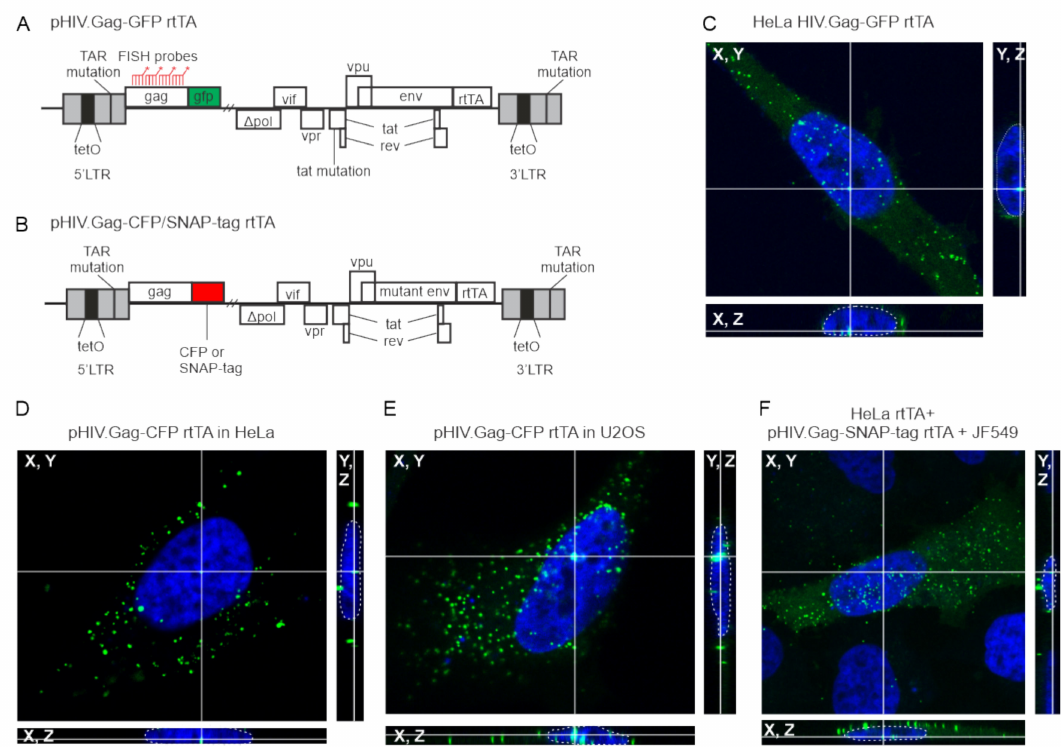
Figure 1. HIV-1 Gag foci are present in the nucleus of HeLa and U2OS cells regardless of the nature of the tag fused to the C-terminus of Gag, which was expressed in a Rev-dependent fashion using the constructs shown in panels A and B. ( A ) Schematic of doxycycline-inducible HIV.Gag-GFP rtTA proviral construct expressing Gag fused to GFP, which is stably integrated in HeLa cells (HeLa HIV.Gag-GFP rtTA). The 5 (cid:48) LTR contains a mutated TAR, two NF- κ B sites, eight copies of the tetO sites in the promoter, and three SP1 sites. ( B ) Schematic of pHIV.Gag-CFP / SNAP-tag rtTA doxycycline-inducible construct with the same 5 (cid:48) UTR sequences described in panel A, which expresses Gag fused to either CFP or SNAP-tag. ( C ) HeLa HIV.Gag-GFP rtTA cell line contains the stably-integrated proviral construct shown in panel A. Numerous Gag foci (green) were seen in the nucleus, which was stained with DAPI (blue). Three-dimensional reconstruction of a confocal z-series is shown with crosshairs through a single Gag focus to demonstrate that Gag was present inside the nucleus (outlined by a dashed white line) in all three planes. ( D ) HeLa cells co-expressing pHIV.Gag-CFP rtTA with pPB-t-rtTA. ( E ) U2OS cells transfected with pHIV.Gag-CFP rtTA and pPB-t-rtTA. ( F ) A HeLa cell line stably expressing